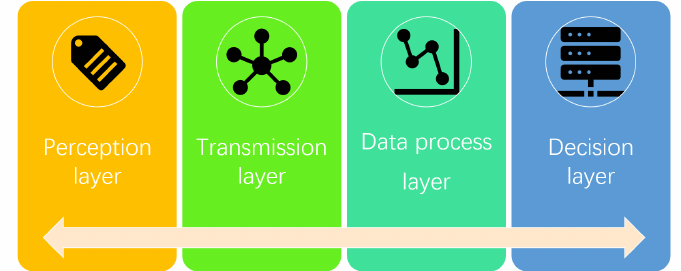
Figure 10. The workflow of AI-enhanced IoT warning system structure